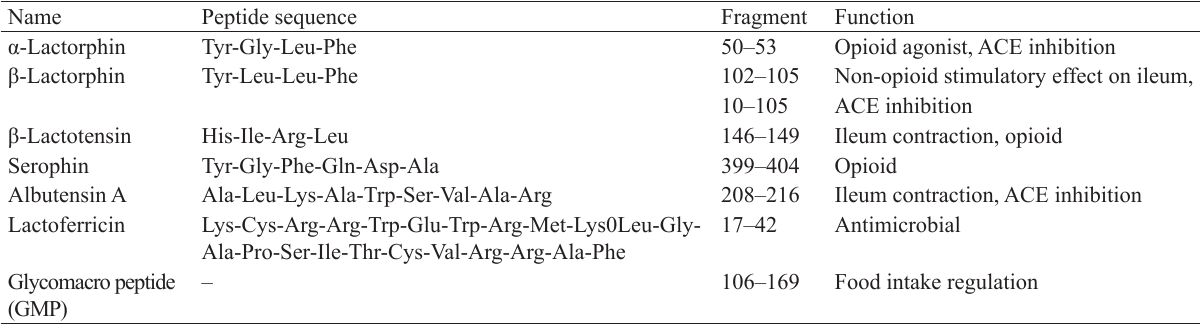
Table 2 Bioactive peptides derived from whey proteins